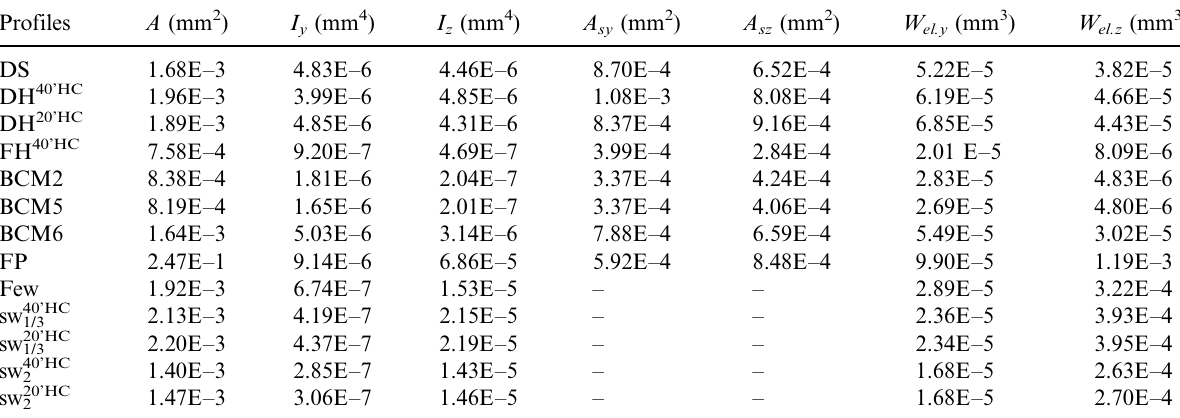
Table 8. Geometrical properties (effective sections) Profiles